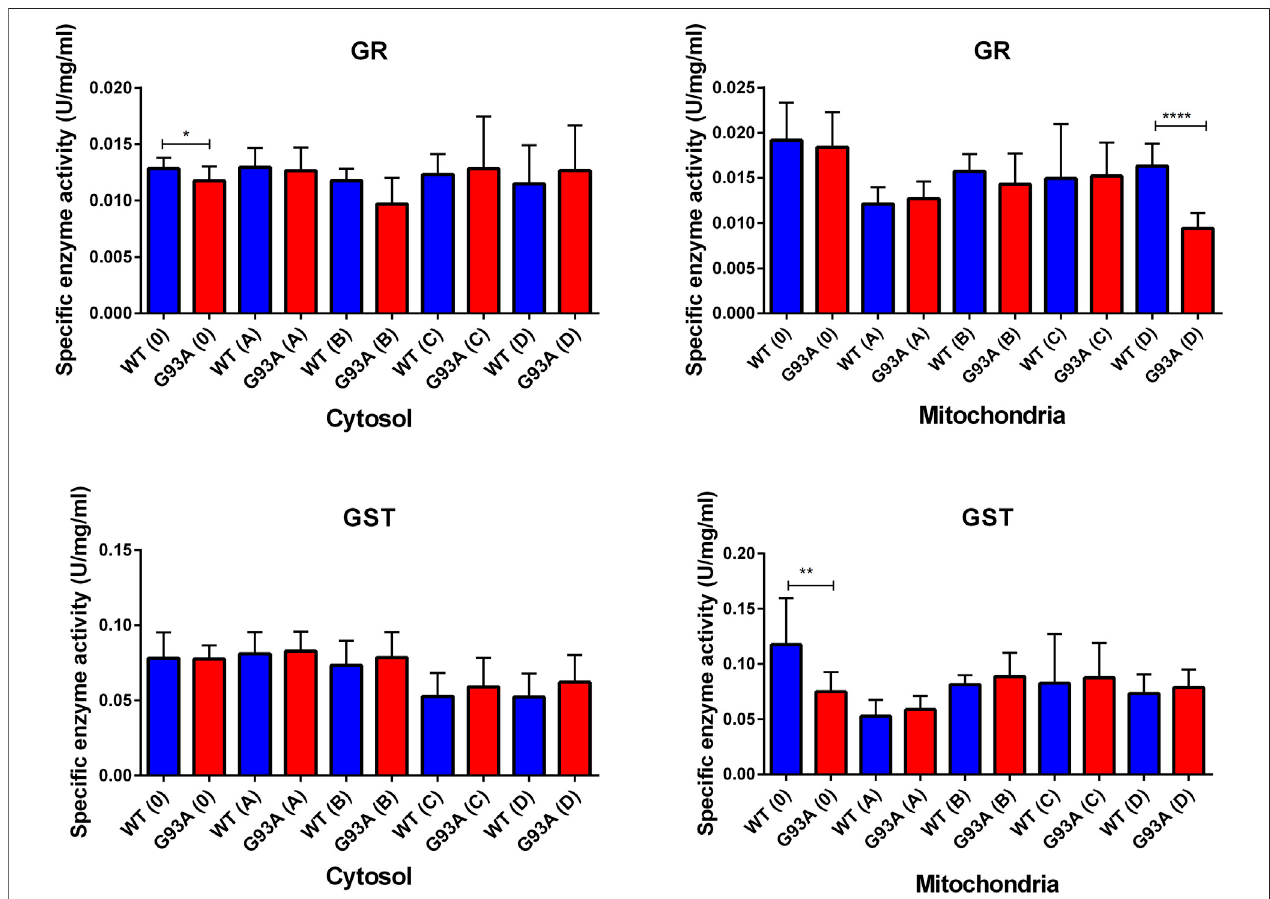
FIGURE8| GRandGSTenzymeswereevaluatedinbothcytosolandmitochondriaoflungtissuesofSOD1 WT (WT)andSOD1 G93A (G93A)rats.Dataweregivenas mean ± SD of n = 8 animals for each group. Notes: * p ≤ 0.05, ** p ≤ 0.001 and *** p ≤ 0.0001.